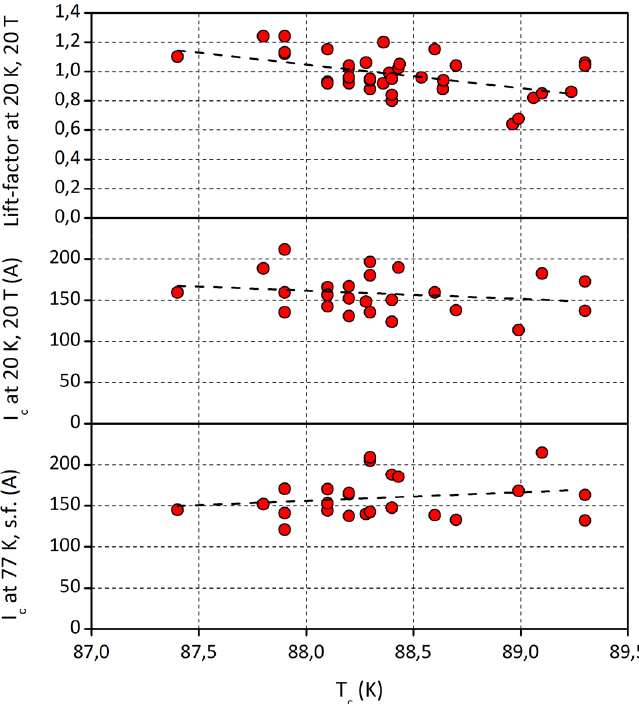
Figure 5. The correlation between the T c of YBCO films and their superconducting properties at 77 K, self-field and 20 K, 20 T. The higher oxygen content in YBa 2 Cu 3 O 7-δ results in overdoping of YBCO with charge carriers and leads to the lower T c and lower I c at 77 K in self-field, but to the higher I c and greater lift-factor values at 20 K, 20